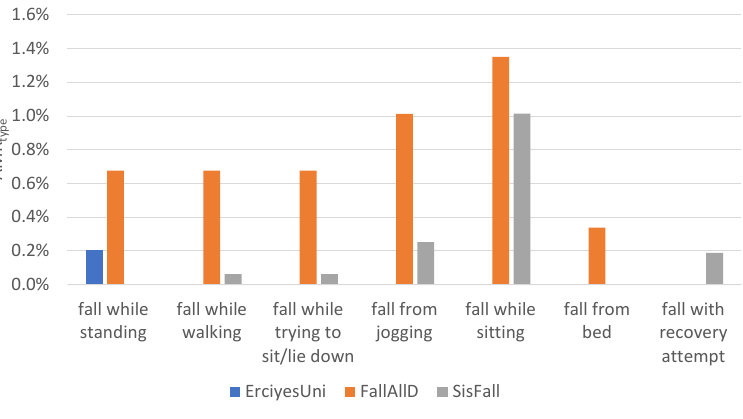
Figure 9. Percentage of all falls misclassified as ADL, grouped by fall types ( AMR type